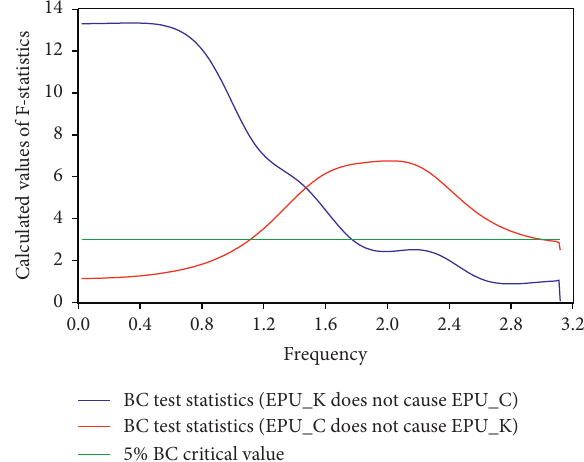
Figure 2: The frequency domain causality between China’s and India’s EPU indices. The part of the lines mentioned above the critical value-line indicates rejection of the null hypothesis of no Granger causality.